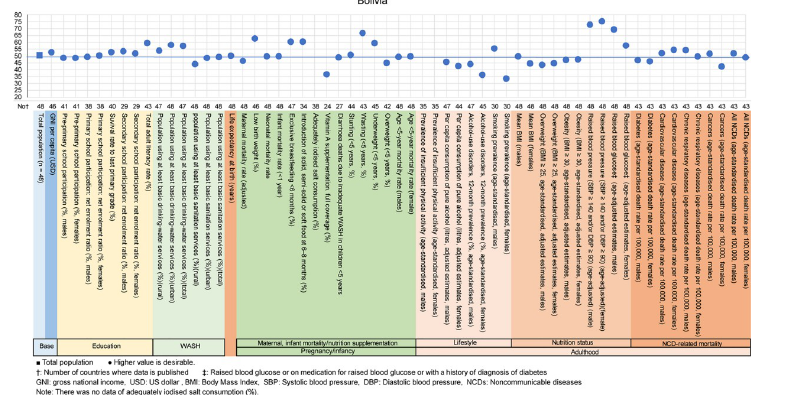
Fig 1. Country diagnosis by the deviation graph for Bolivia.